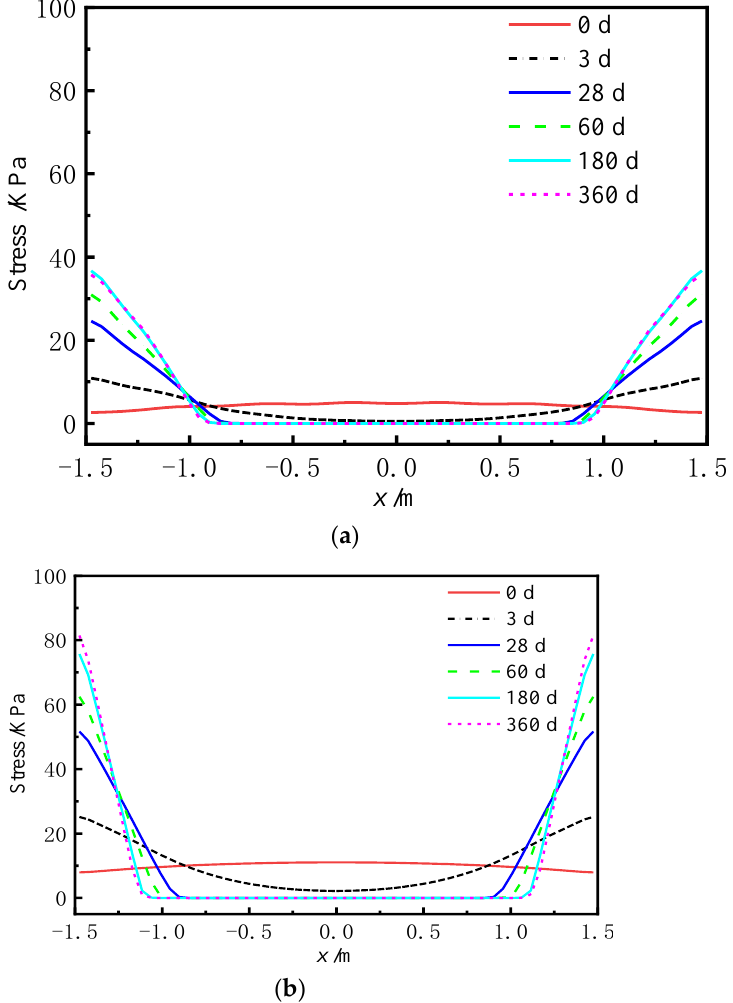
Figure 17. Normal stress of the sliding layer at the AOTSL of 360 d. ( a ) With the shear cogging. ( b ) Without the shear cogging.